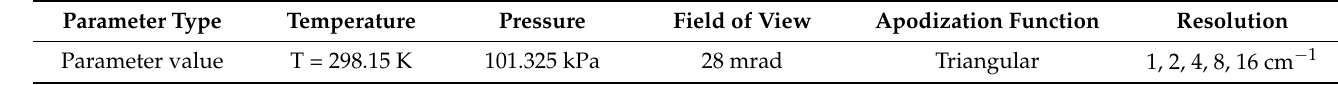
Table 5. Inversion parameters in quantitative analysis.